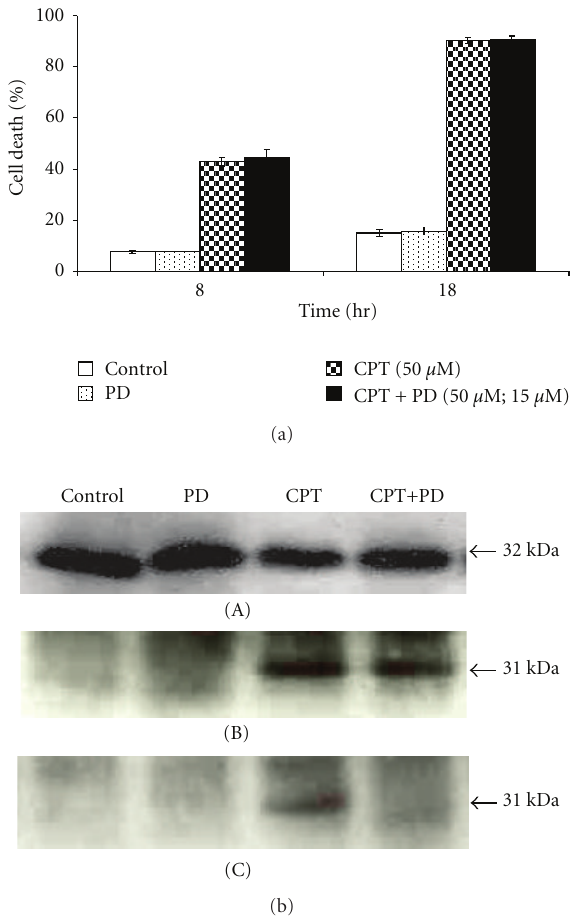
Figure 2: Inhibition of calpain does not protect fibroblast C8 cells from CPT-induced cell death or activation of Cdk5. (a) C8 cells were exposed to 50 μ M CPT in the presence or absence of 15 μ M calpain inhibitor, PD, for 8hours or 18 hours. The amount of cell death was measured by trypan blue exclusion. The error bars represent the standard deviation from at least three individual experiments. CPT killed ∼ 40% of the cells within 8 hours and ∼ 90% by 18 hours, but PD did not a ff ect the toxicity. (b) Cells treated with 50 μ M CPT or CPT plus 15 μ M PD were collected and lysed by RIPA bu ff er. (A) Western blot of Cdk5 in equal amounts of cell lysates from cells treated with CPT or CPT + PD for 18 hours showed an unchanged level of Cdk5 protein (32kDa) during cell death. ((B) and (C)) Histone H1 kinase activity of Cdk5 immunoprecipitates was measured using histone H1 as substrate. The histone H1 phosphorylated by Cdk5 was detected by western blot (31kDa). The kinase activity reflected the amount of cell death induced, following 8-hour (B) or 18-hour (C) treatment with CPT in the presence or absence of PD. PD did not a ff ect the amount of histone kinase activity seen at 8hours, though by 18 hours more was lost in the presence of PD than in its